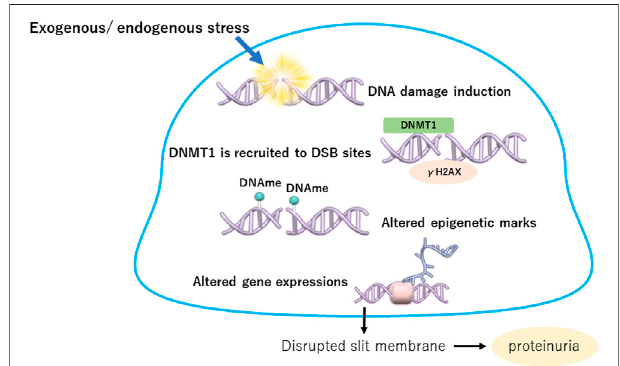
FIGURE2| DNAdamagerepairinpodocyteshighlightingtheepigenetic aspects. Exogenous or endogenous stress causes DNA damage in podocytes. When damaged, DNMT1 is recruited to DSB sites where it colocalizes with phosphorylated histone H2AX (y H2AX) to silence the repairedgene.IncreasedDNAmethylationdue toDNMT1action mayindicate epigenetic memory denoting former damage, which induces